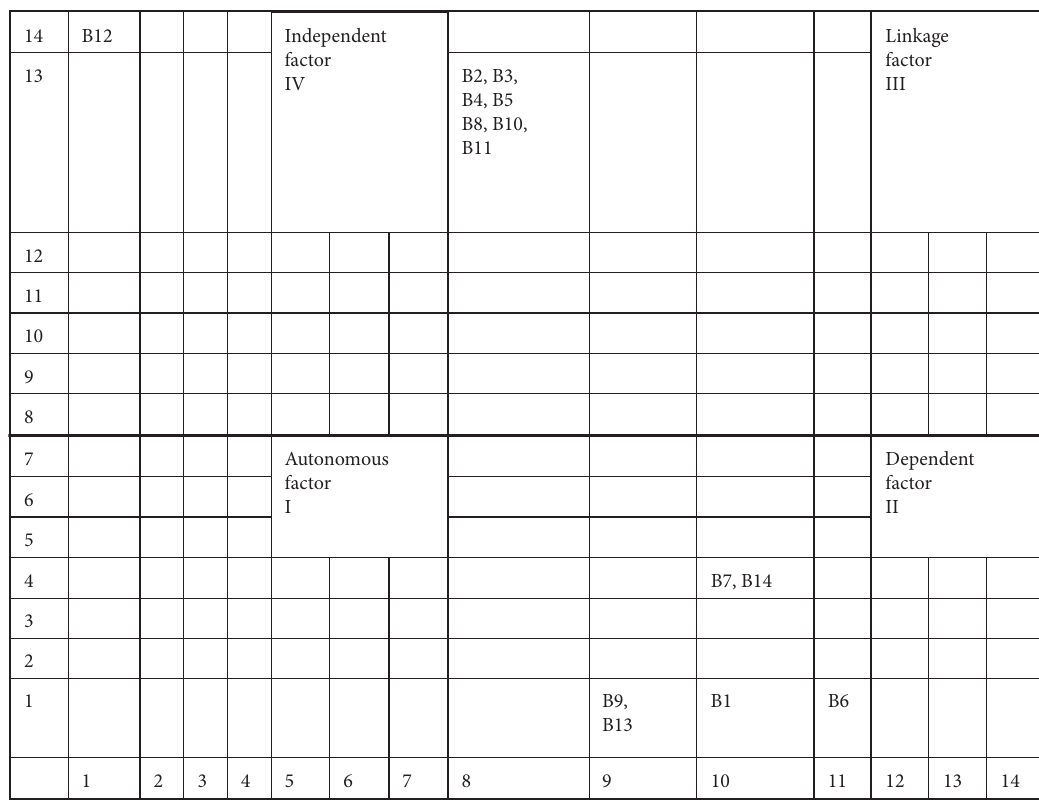
Figure 4: Results of MICMAC analysis of